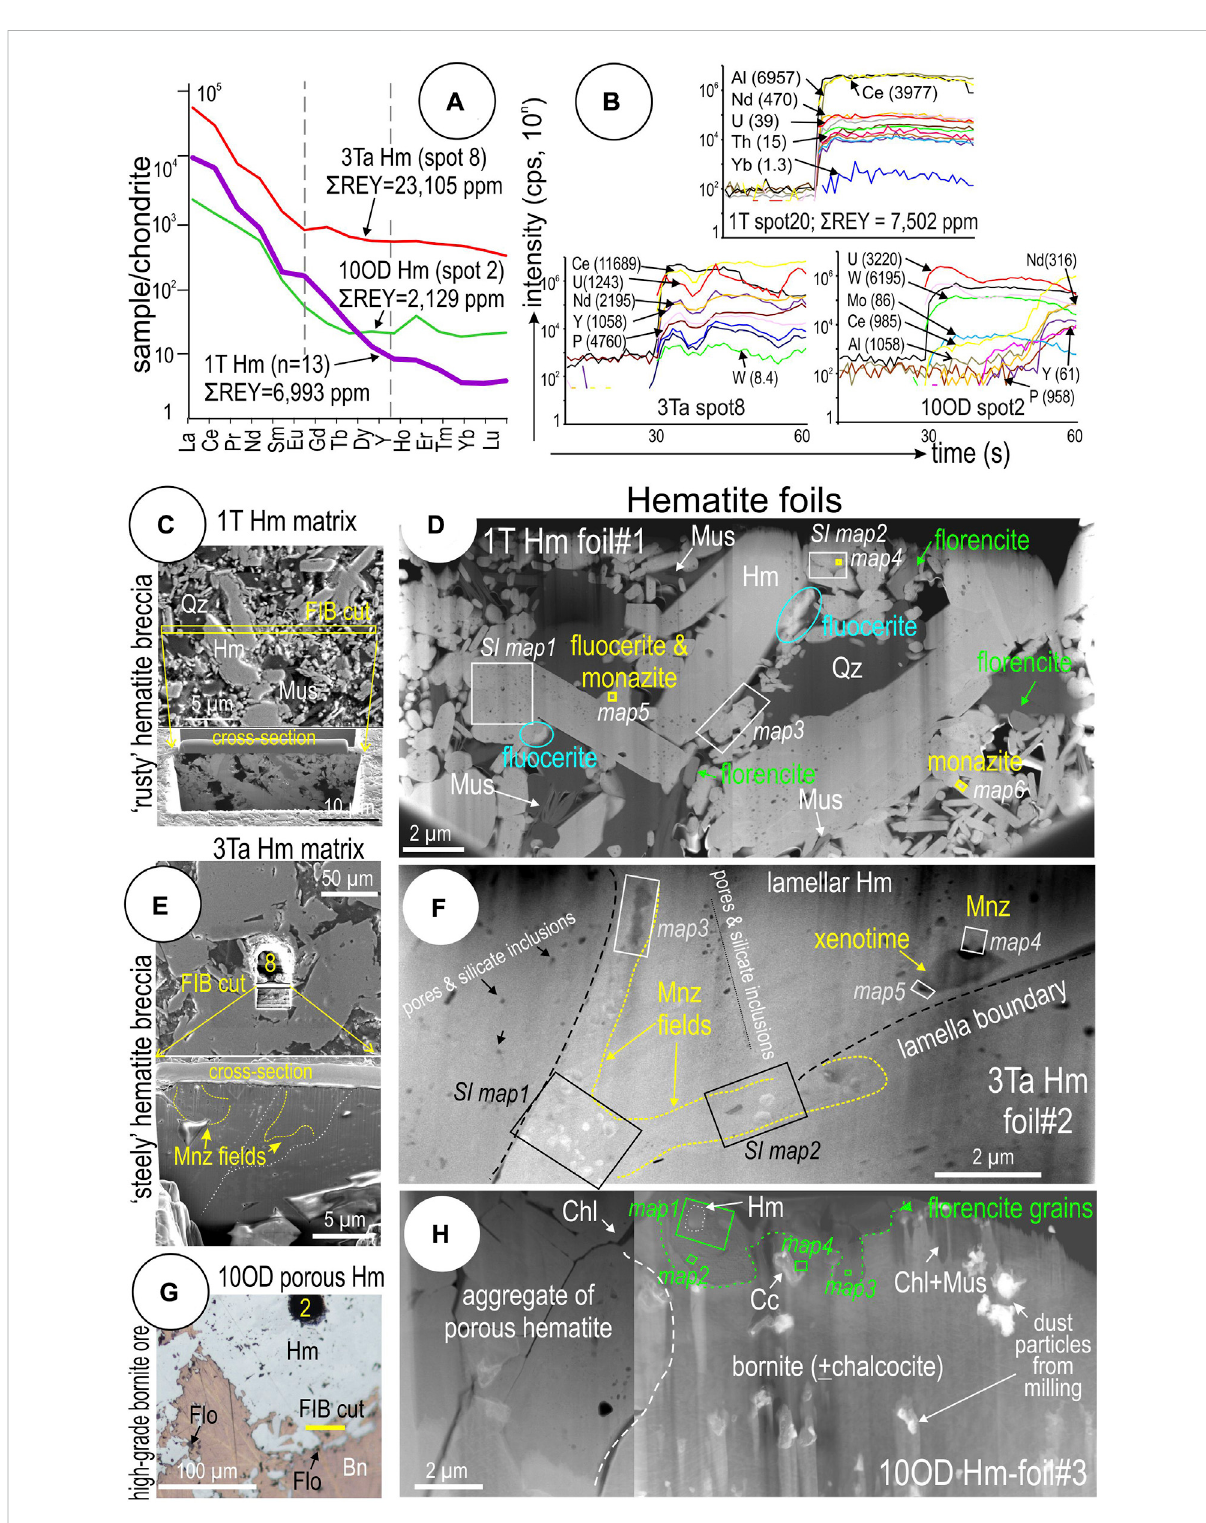
FIGURE 9 (A) Chondrite-normalized REE fractionation trends for representative LA-ICP-MS spot analyses from samples 1T, 3Ta, and 10OD. (B) Time- resolved downhole LA-ICP-MS pro fi les for the three spots. Note relatively smooth signals and high REE concentrations in 1T Spot 20, erratic signals indicativeofinclusionsin3TaSpot12,and fl atandanomaloussignalsrelatedtoinclusionsin10ODSpot2. (C – H) LocationsofFIB-cutsfromsamples 1T, 3Ta, and 10OD, respectively, marked on re fl ected light photomicrograph, and overview of the studied thinned foils. EDS element maps presented in this work are located on the overview